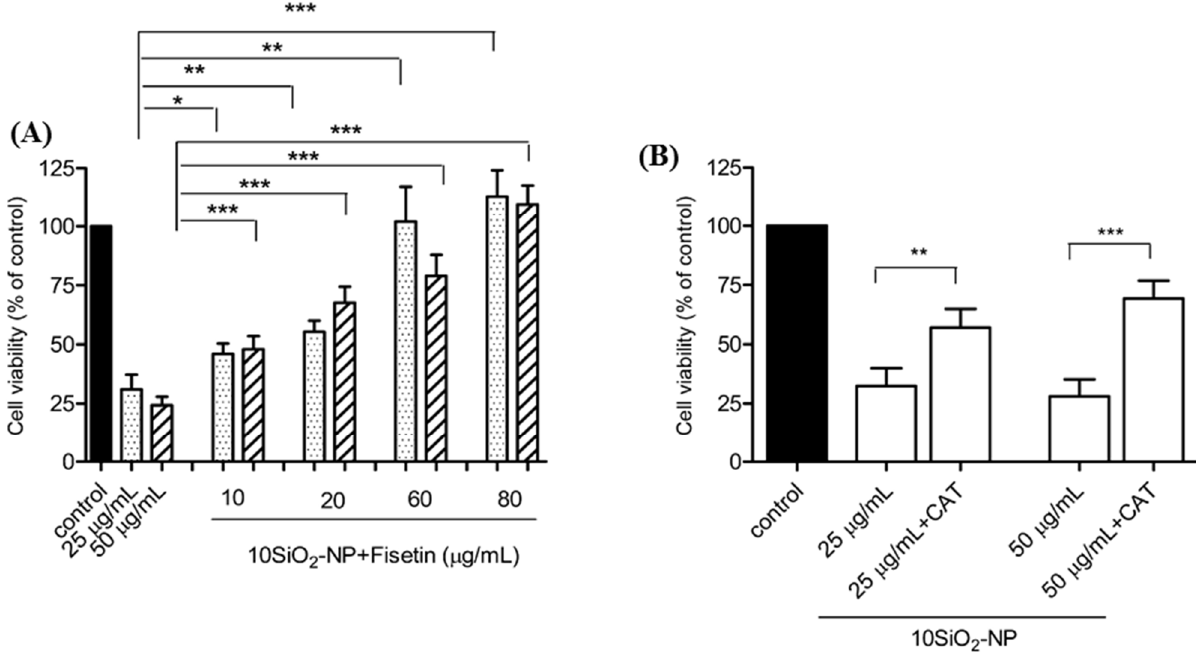
Figure 4. Cell viability of Calu-3 upon incubation with SiO 2 nanoparticles. ( A and B ) Prior incubation of cells with fisetin ( A ) and catalase ( B ) prevented the cell death induced by SiO 2 -nanoparticles (25 and 50 μ g/mL) on Calu-3. * p < 0.05, ** p < 0.01, and *** p < 0.001, n = 3–4. Modified from reference 96 with permission of the